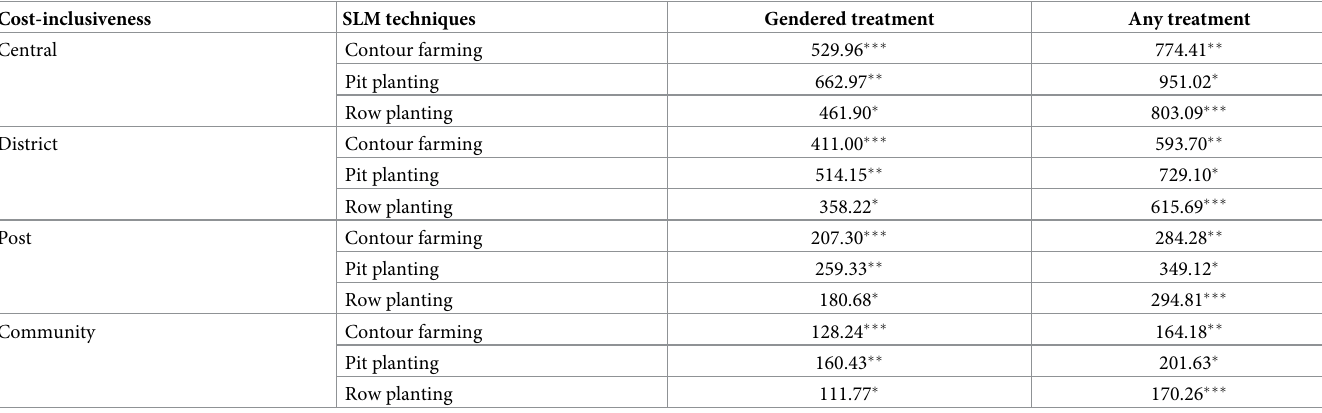
Table 7. CGAAS: Cost-effectiveness of the intervention in increasing SLM awareness.